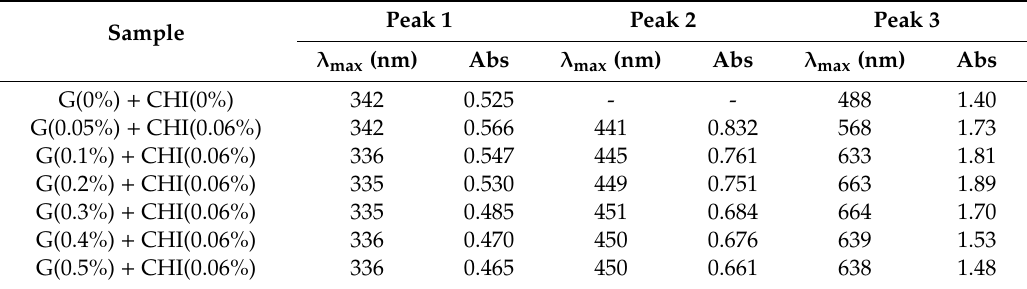
Table 1. UV-Vis results of triangular Ag nanoplates synthesized by di ff erent concentration ratios of gelatin–chitosan mixture.